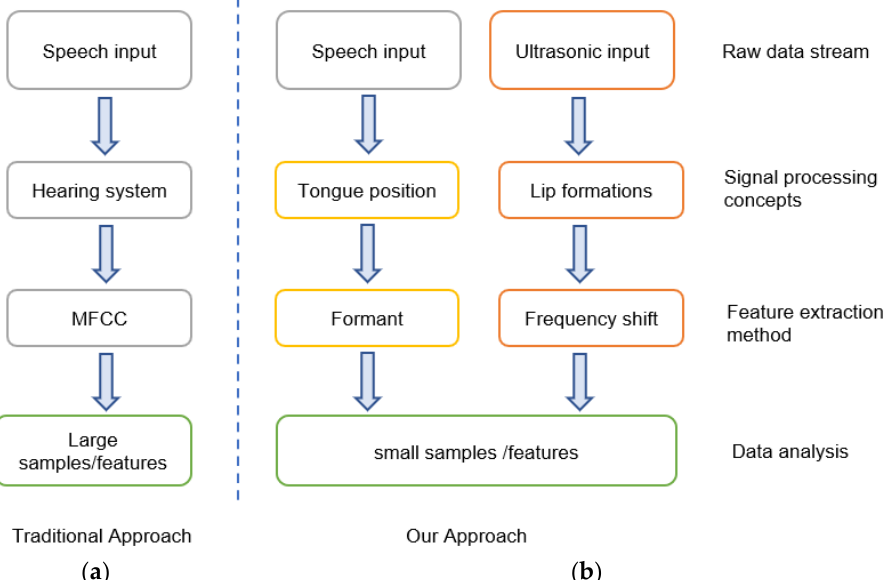
Figure 2. The system frameworks: ( a ) the traditional approach using the speech processing method converts the speech signal to a sequence of MFCCs, resulting in a large sample size; ( b ) the proposed system simultaneously uses speech and ultrasonic signals without requiring large sample sizes to support articulation-based identification.